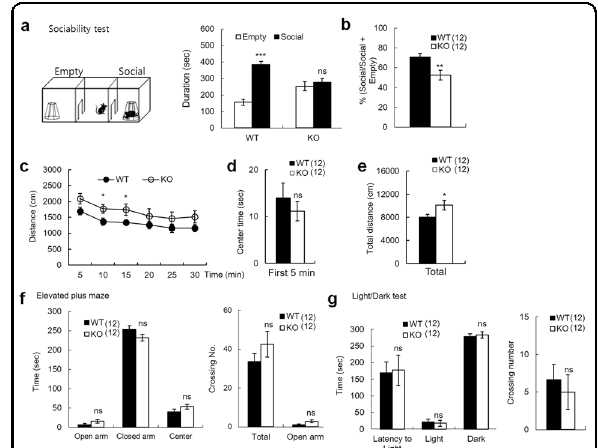
Fig. 1 Decreased social interaction but normal locomotion and anxiety-like behavior in the adult PRMT7 KO mice. a , b Social approach (three-chamber) test. a illustrates the time spent interacting with an empty cup or a cup with a strange mouse inside, which is shown for each genotype. Paired Student ’ s t test comparing “ mouse ” to “ empty ” as a measure of sociability within each group. *** p < 0.001; ns, not signi fi cantly different. b illustrates the preference for the strange mouse, calculated as [(time spent exploring stranger mouse)/ (total time spent exploring stranger mouse and empty cup)] × 100%. ** p < 0.01; Student ’ s t test. c – e Normal locomotor activity of the PRMT7 KO mice (3 months) in open- fi eld tests, as shown by the distance moved ( c ), the time spent in the center region of the open- fi eld arena ( d ), and the total distance moved for 30 min ( e ). n = 12 for WT and 12 for KO. * p < 0.05; ns, not signi fi cantly different; Student ’ s t test. f Normal anxiety-like behavior o f the PRMT7 KO mice (3 months) in the elevated plus-maze test. n = 12 for WT and 12 for KO. ns, not signi fi cantly different, Student ’ s t test. g Normal anxiety-like behavior of the PRMT7 KO mice (3 months) in the light/dark test. n = 12 for WT and 12 for KO. ns, not signi fi cantly different; Student ’ s t